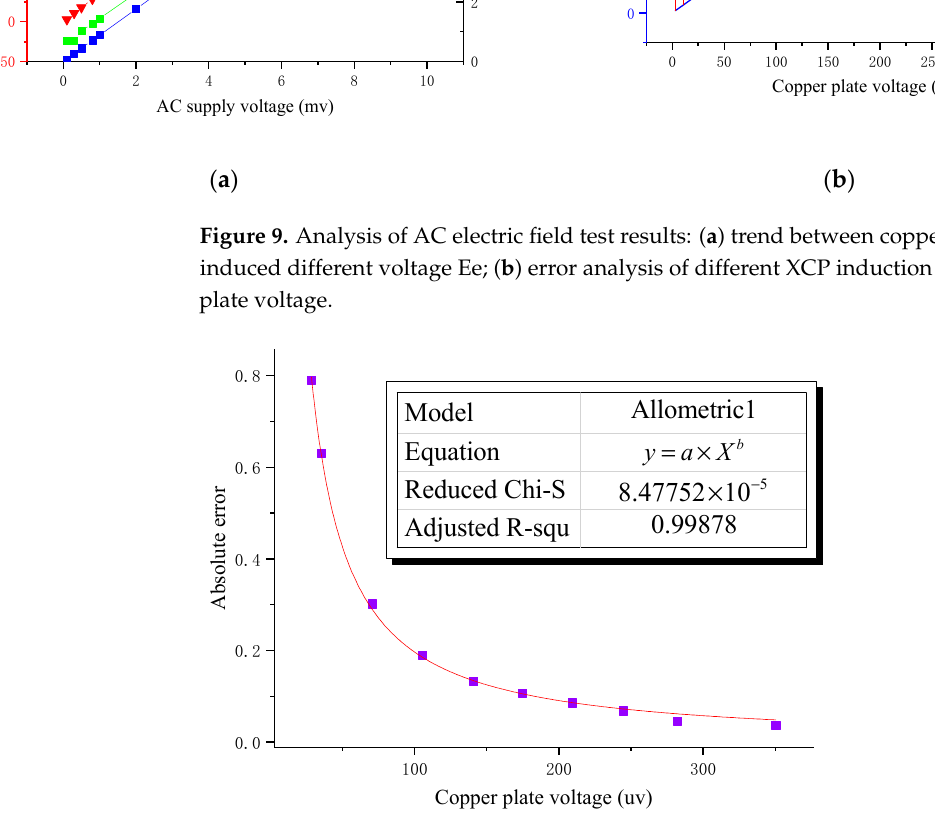
Figure 10. Error optimization fitting model result plot under internal interference.